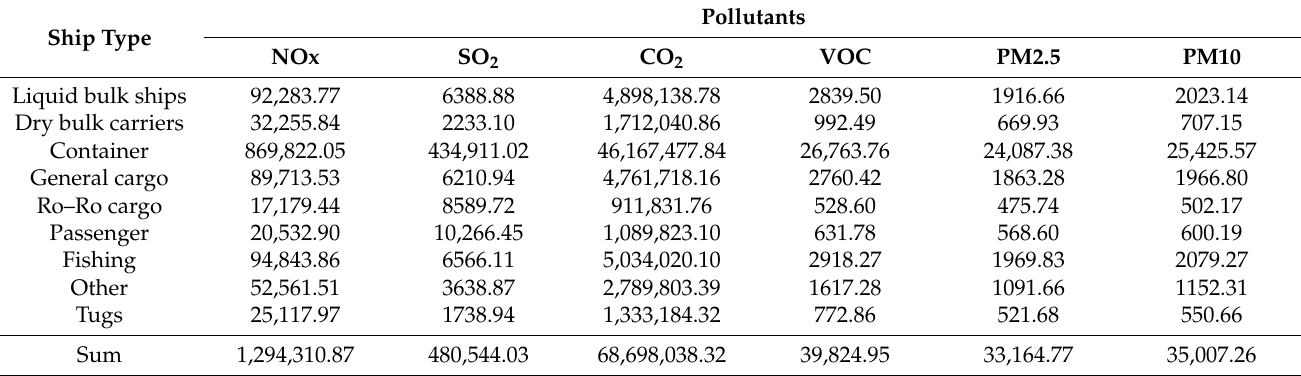
Table A3. Ship pollutant emissions by ship type at Busan Port in 2017 (ship activity phase: Hoteling) [kg].